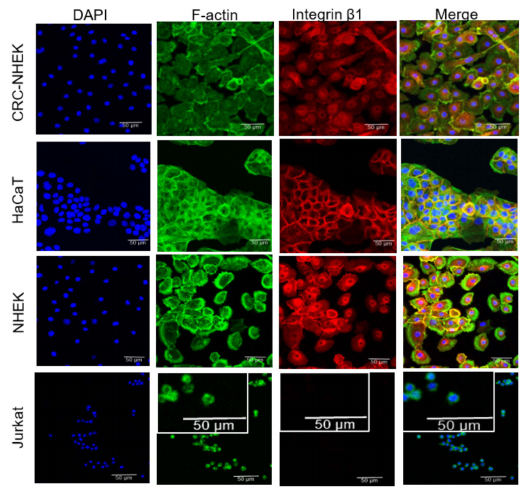
Figure 2. Human keratinocytes, CRC-HFK, HaCaT, and NHEK, but not Jurkat T cells, demonstrate strong integrin- β 1 expression. Cells were stained with integrin- β 1 antibody and coupled to Qdot-655. Nuclei were stained with DAPI. The cytoskeleton compartment was labeled with FITC-F-Actin. Jurkat cells were used as a negative